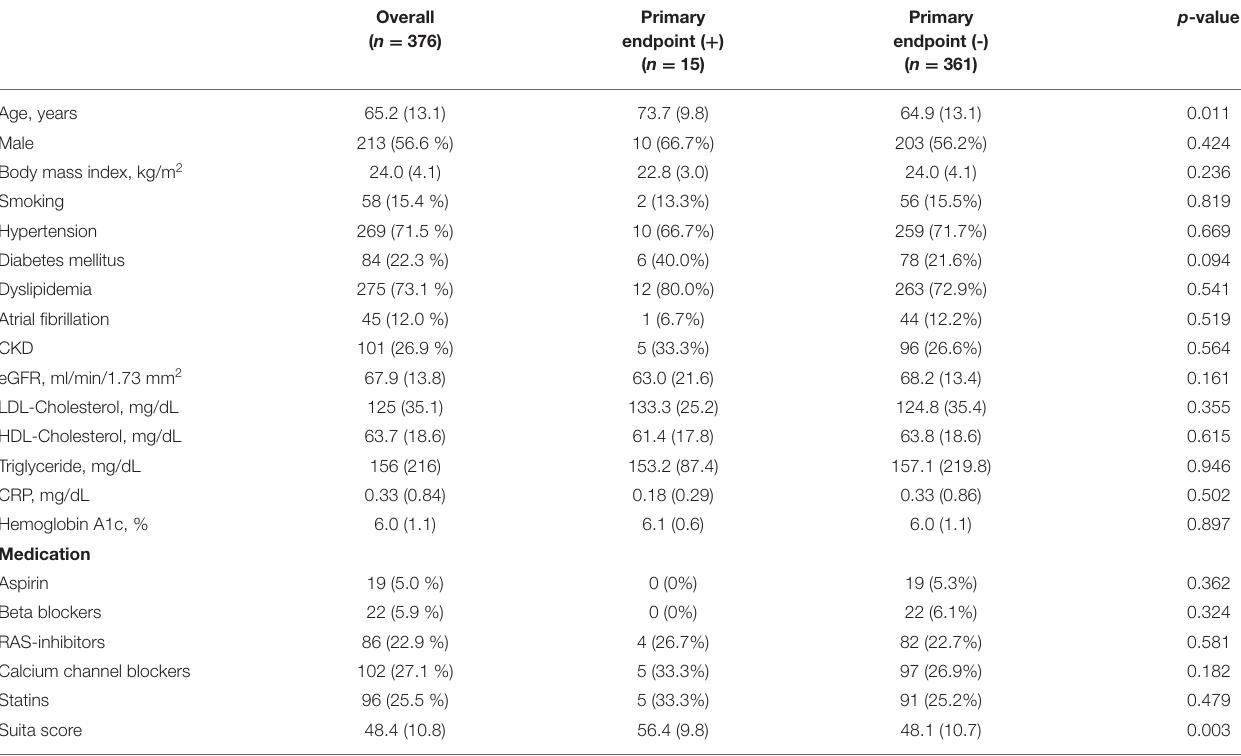
TABLE 1 | Baseline patient